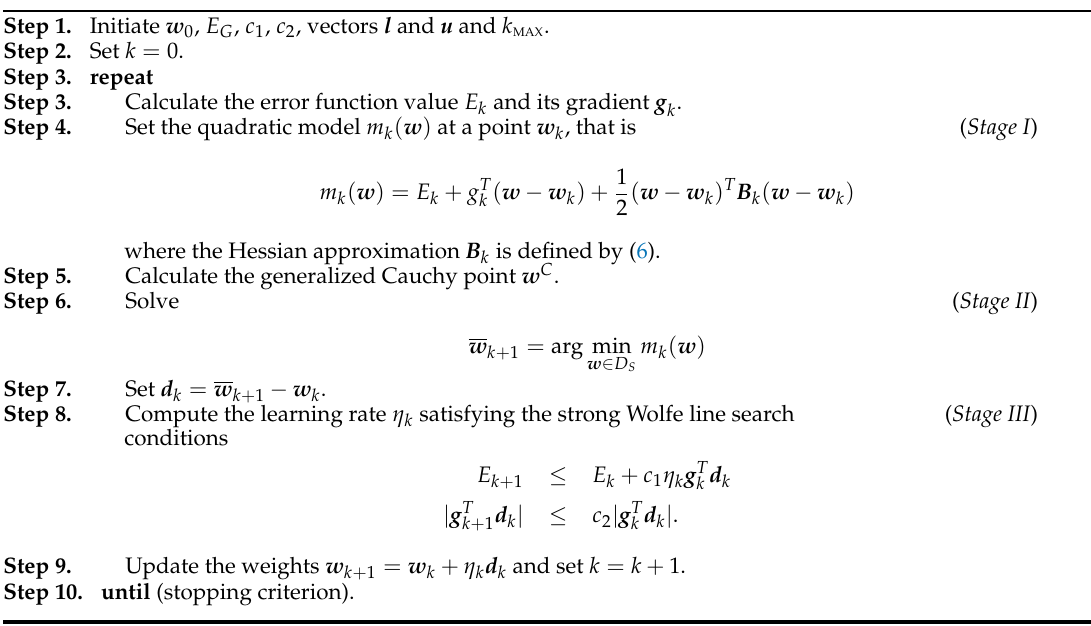
Algorithm 1: Weight Constrained Neural Network Training